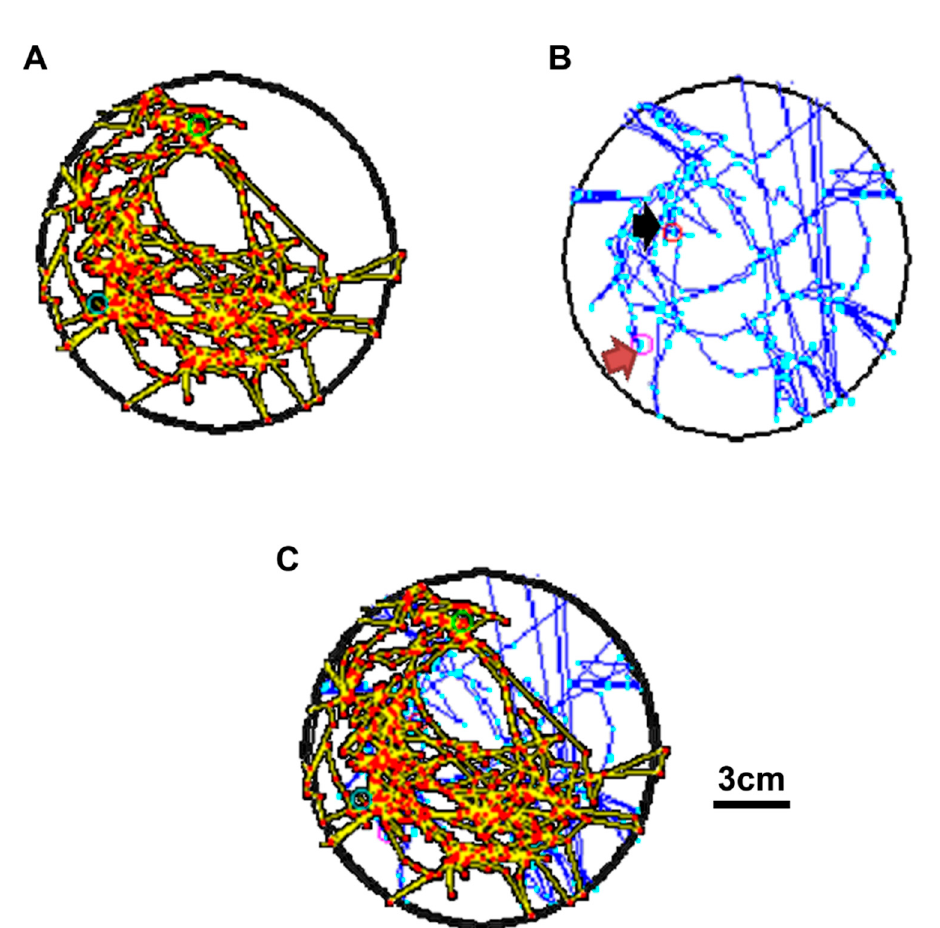
Figure 11. Social interaction test with optogenetic photostimulation. To test social interaction behavior, two animals were placed in the magnetic field, and the optical fiber was implanted into the medial prefrontal cortex (mPFC). ( A , B ) Using an auto-tracking device, the distances traveled by each animal are respectively drawn. ( C ) The picture combines the distances traveled by two animals with photostimulation in the social interaction test. The black arrow represents the starting point, and the red arrow represents the ending point.